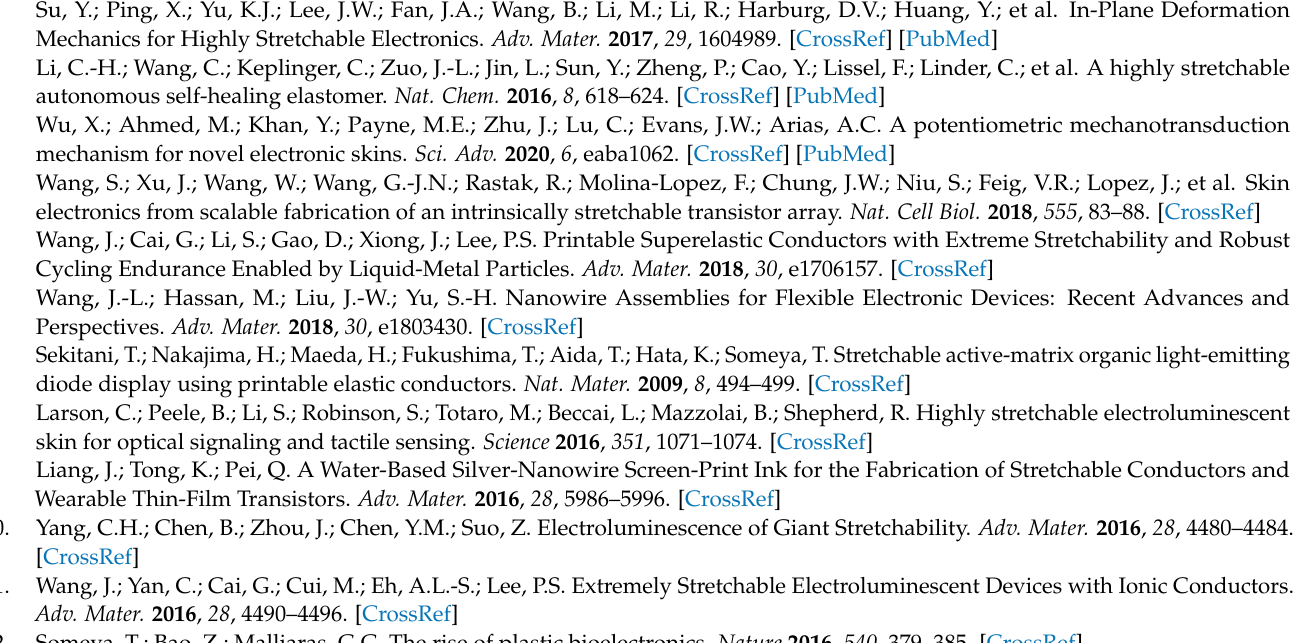
Figure S2: Representative voltage at constant current for a not pre-stretched SWCNT sample and a